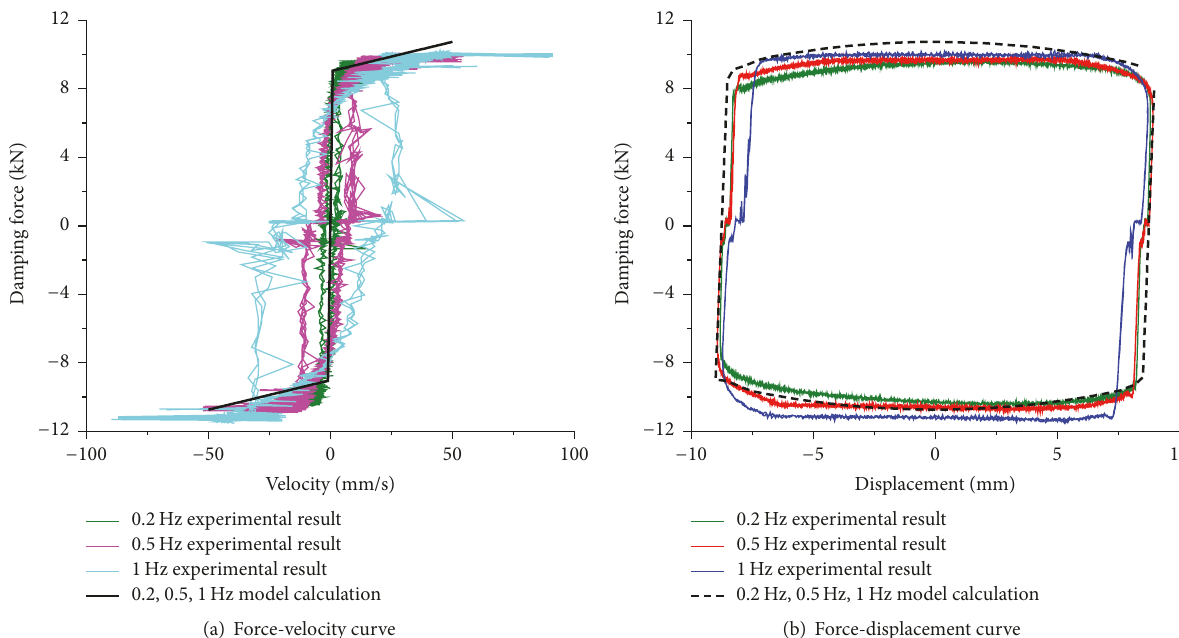
Figure 7: Comparison between model calculation and experimental results for different frequencies.